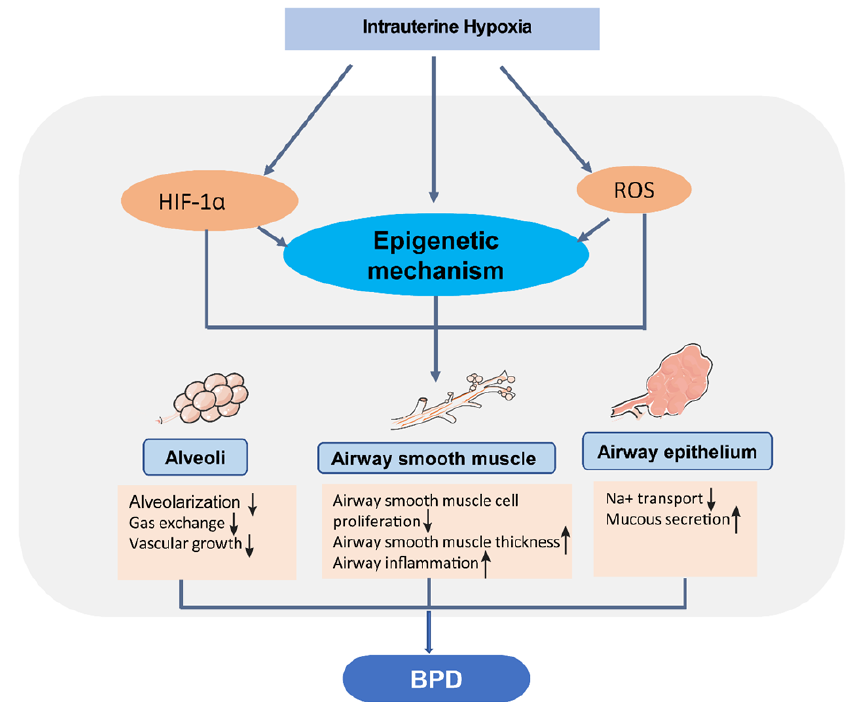
Figure 2. Intrauterine hypoxia increases the susceptibility to BPD. Intrauterine hypoxia results in different pathophysiological phenotypes of the alveoli (for example, defects in alveolarization, gas exchange, and blood vessel growth), airway smooth muscle (for example, reduction of airway smooth muscle cells proliferation and increased airway smooth muscle thickness and inflammation) and airway epithelium (for example, decreased Na + transport and increased mucus secretion). These structural or functional defects mediated by hypoxia signals lead to infant BPD